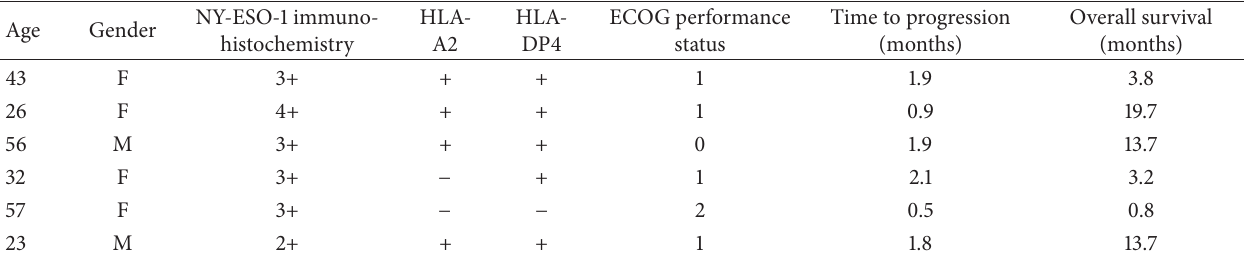
Table 1: Patient